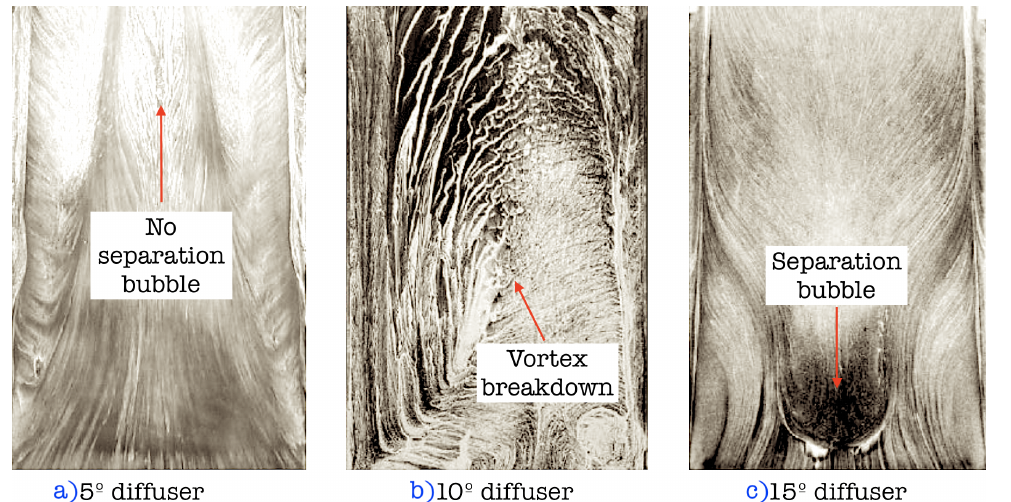
Figure 8. Surface flow visualisation at diffuser angles of ( a ) 5 ◦ , ( b ) 10 ◦ and ( c ) 15 ◦ (Reprinted with permission from the University of Southampton